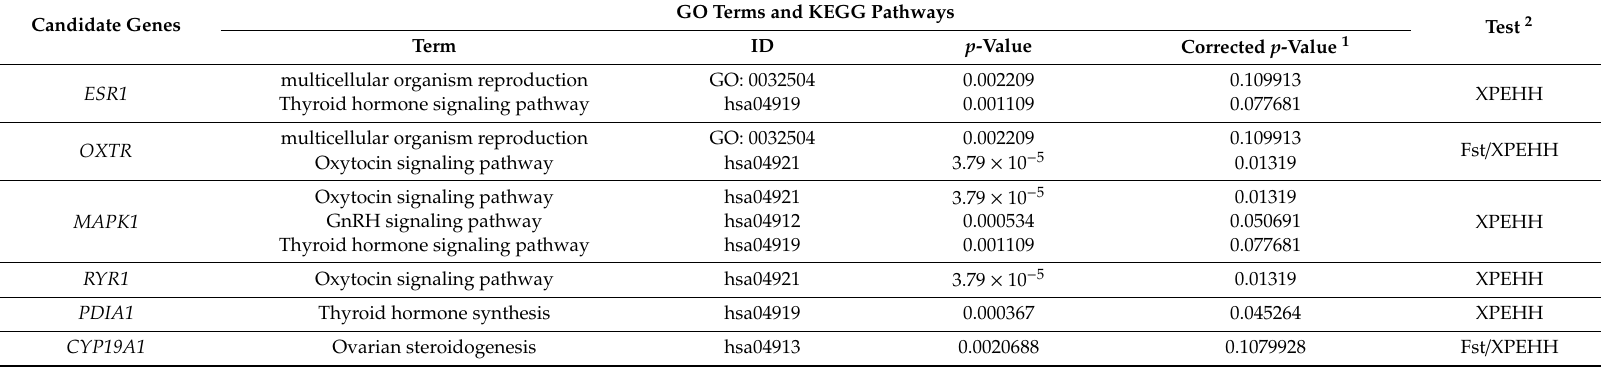
Table 3. The candidate genes for litter size under selection in three multiparous sheep breeds from the critical KEGG pathways and GO terms. Candidate